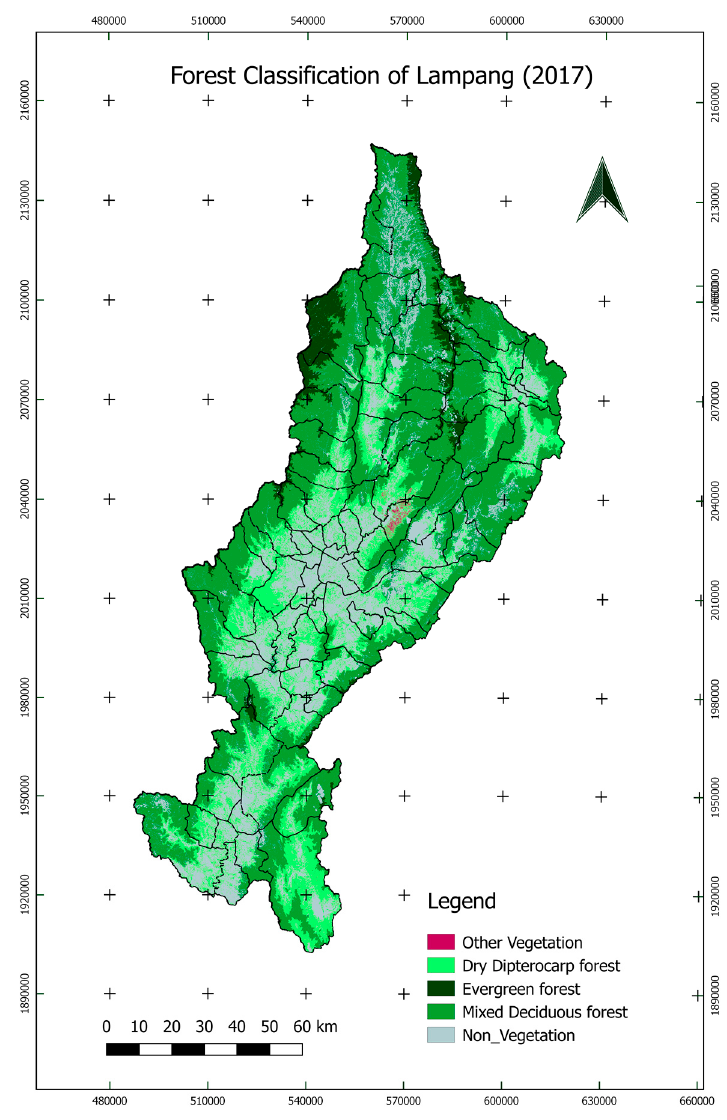
Figure 6. Forest classification map in Lampang (2017).